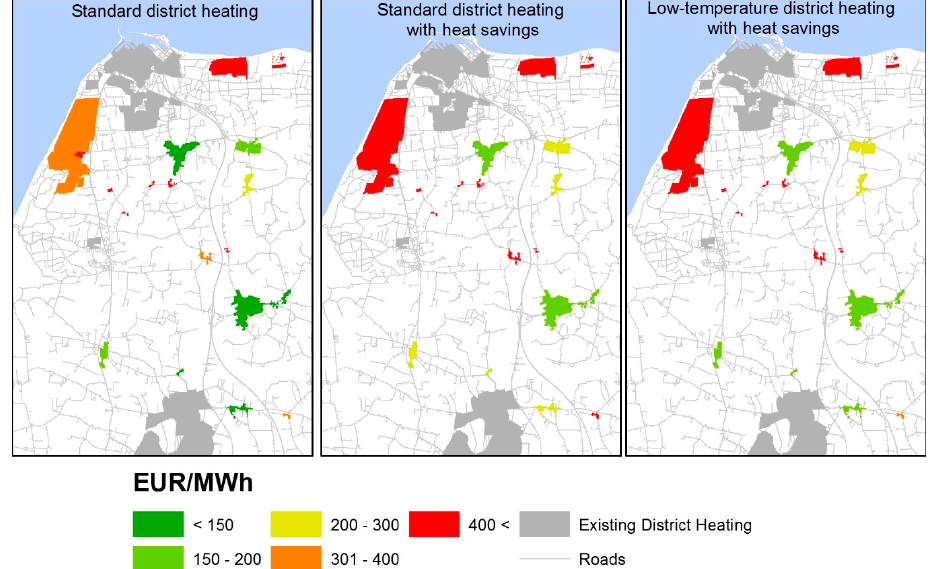
Figure 7. Example of map output for the area of Hirtshals.